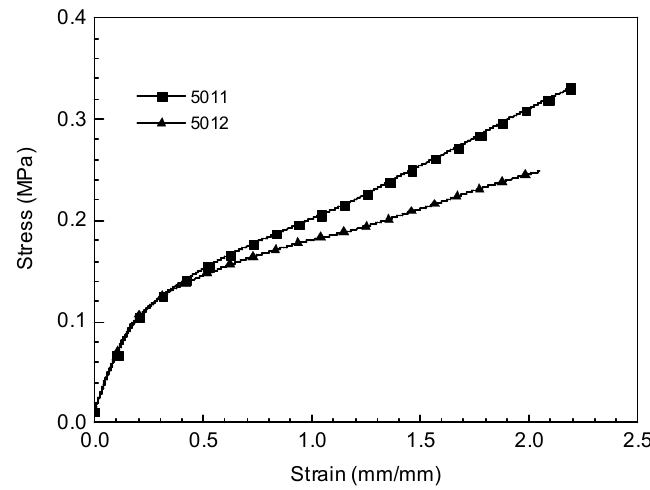
Figure 7. Stress–strain curve of coatings. Table 4. Mechanical property parameters of coatings.